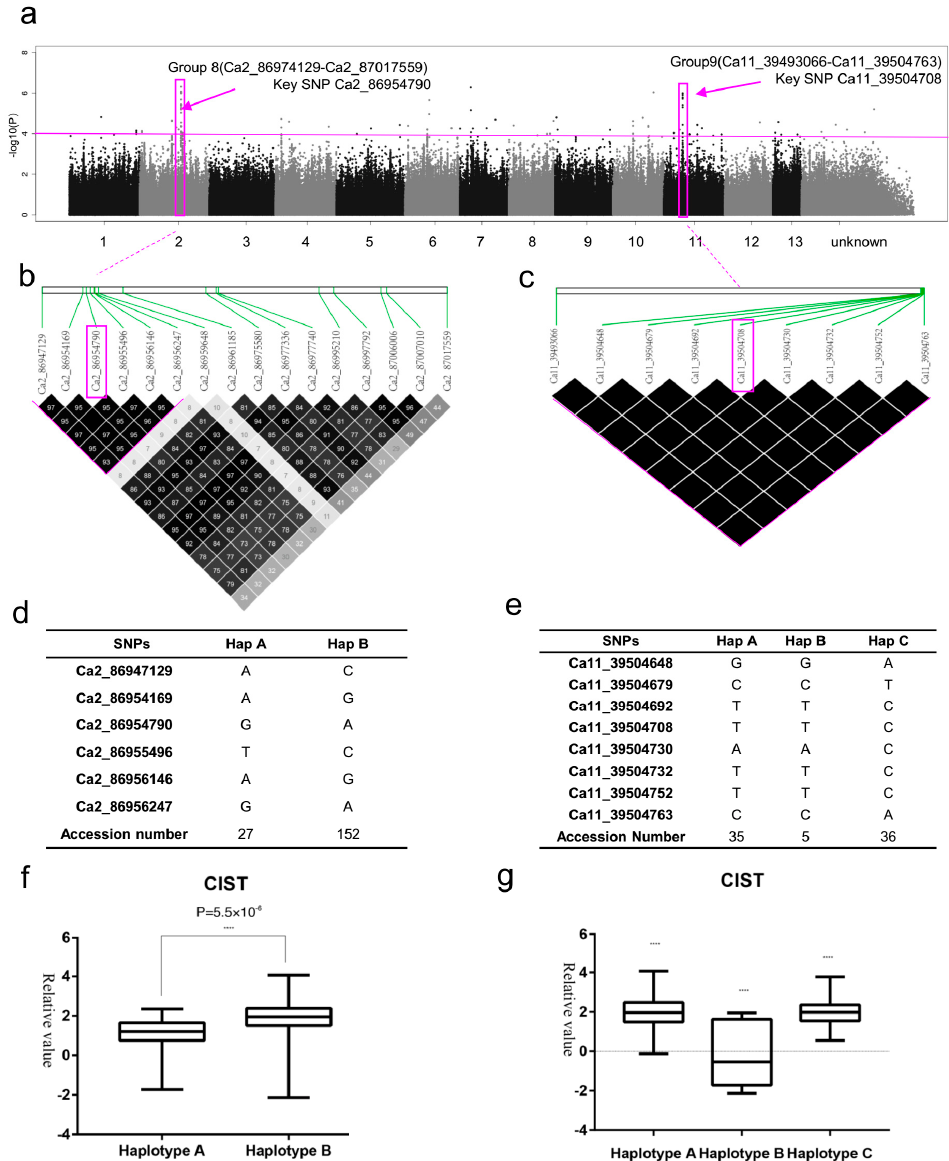
Figure 6. GWAS results for CIST and analysis of the peaks on chromosome 2 and 11. ( a ) Manhattan plot for CIST. The horizontal line represents the significant threshold ( − log10P = 4). The pink color surrounds represent SNP rich regions (Group 8 and Group 9). ( b ) LD surrounding the peak of Group 8. ( c ) LD surrounding the peak of Group 9. ( d ) Haplotypes in Group 8. ( e ) Haplotypes in Group 9. ( f ) Phenotypic differences of CIST between two haplotypes in Group 8. ( g ) Phenotypic differences of CIST among three haplotypes in Group 9.